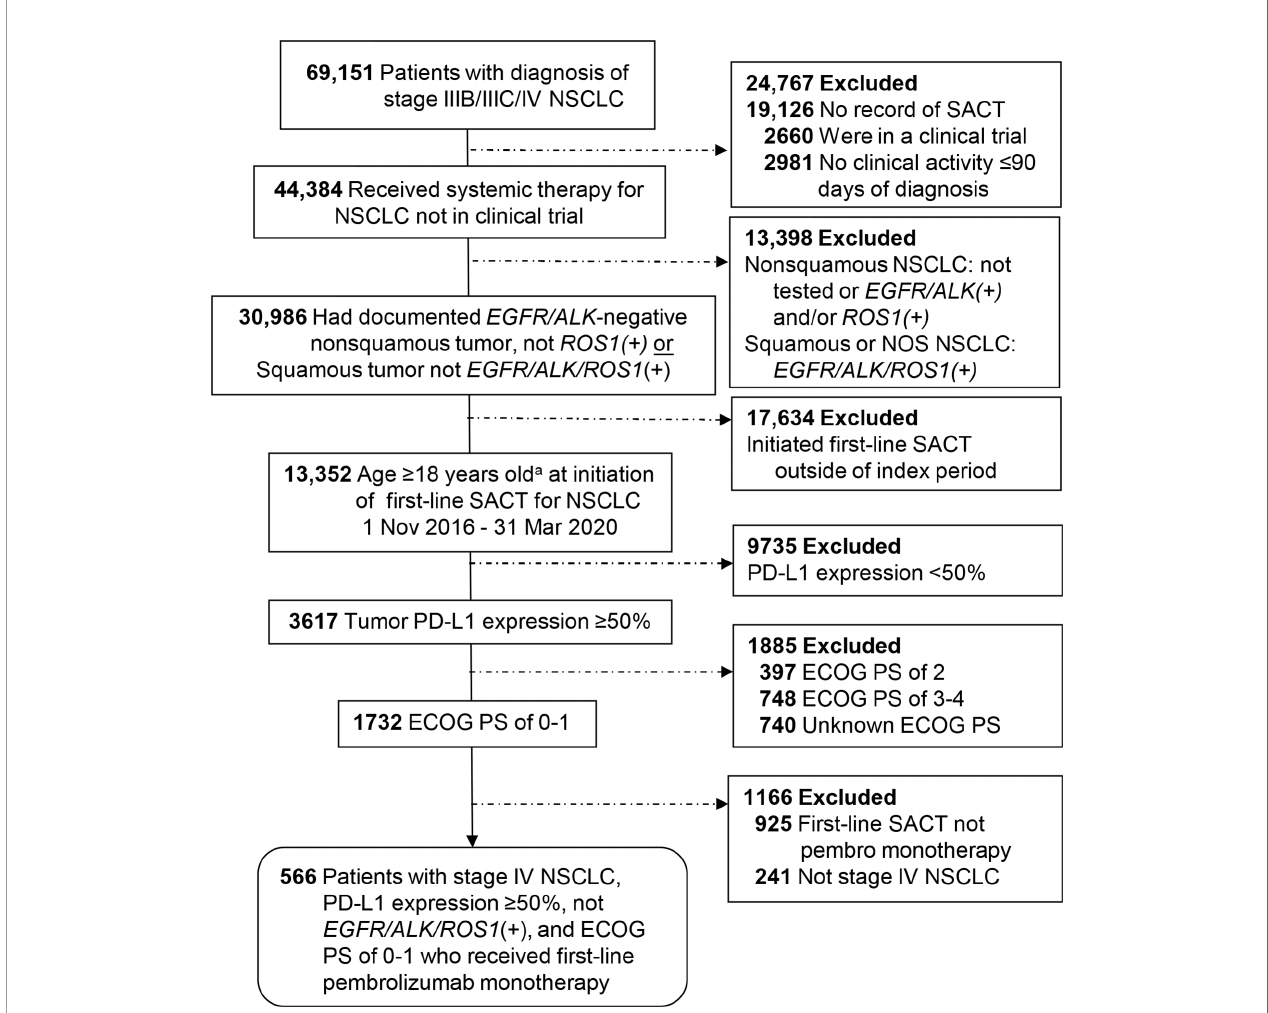
FIGURE 1 | Patient selection for the EHR cohort from the Flatiron Health Database. a No patients were excluded for being <18 years of age. ECOG PS, Eastern Cooperative Oncology Group performance status; NSCLC, non-small cell lung cancer; PD-L1, programmed cell death-ligand 1; SACT, systemic anticancer